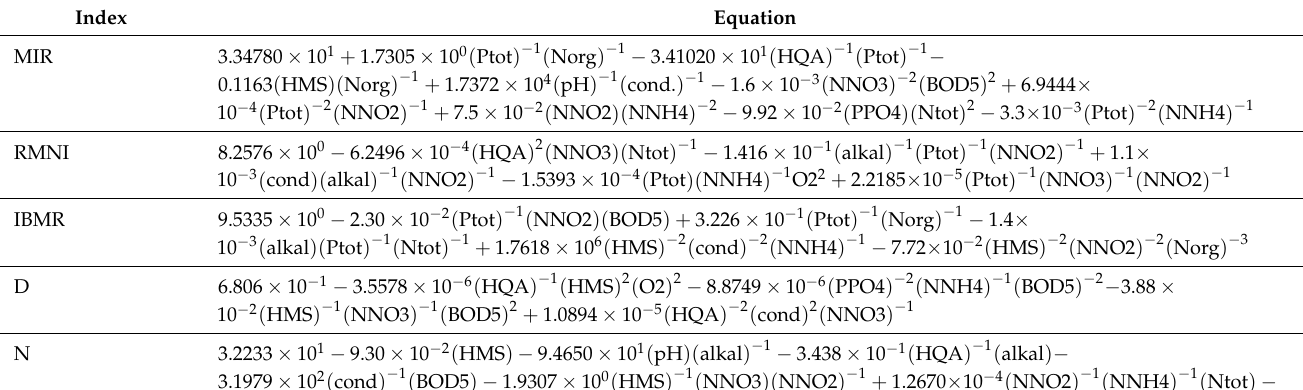
Table 2. Polynomial equation for each MPR model (the notations follow Table 1).